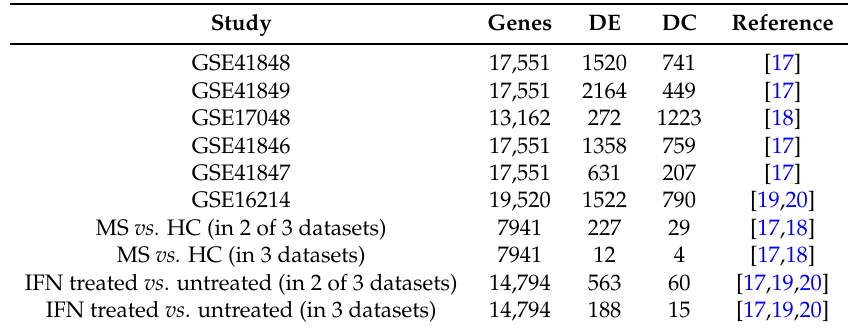
Table 2. Number of differentially-expressed (DE) and differentially-connected (DC) genes for each analyzed dataset and confirmed in 2 or 3 experiments. Note that in the column entitled “Genes”, for the genes confirmed in more experiments, we reported the number of common genes among the different